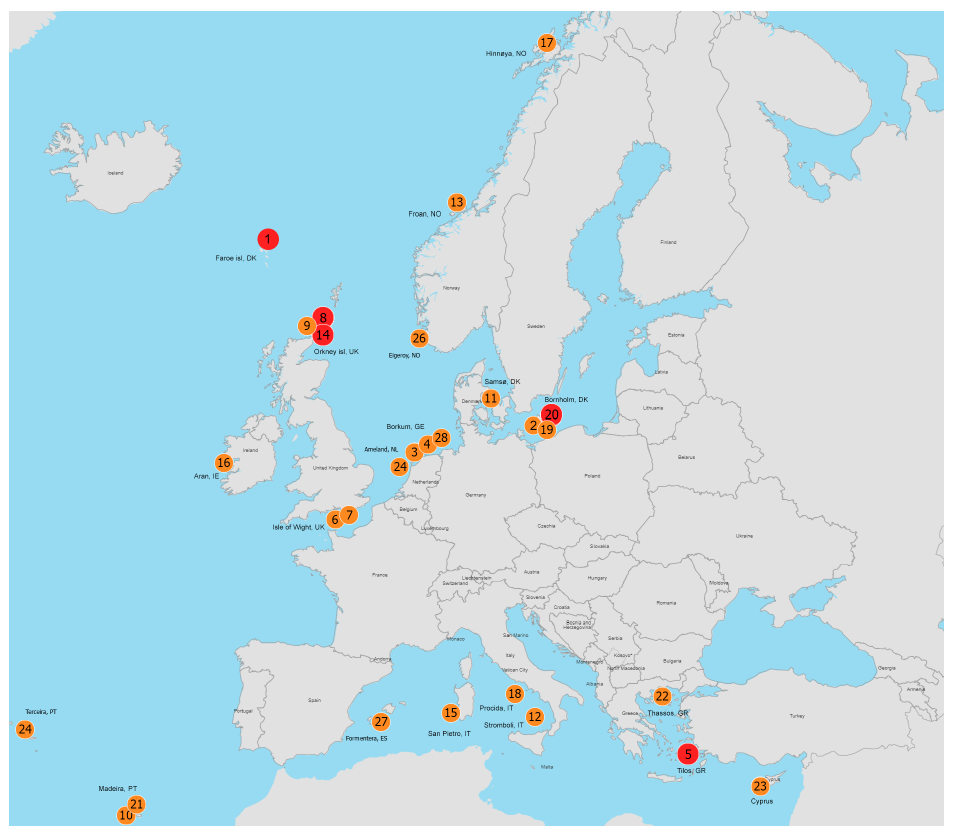
Figure 2. Multi-energy demo pilot locations. Orange–medium-scale use cases (from 100 kW to